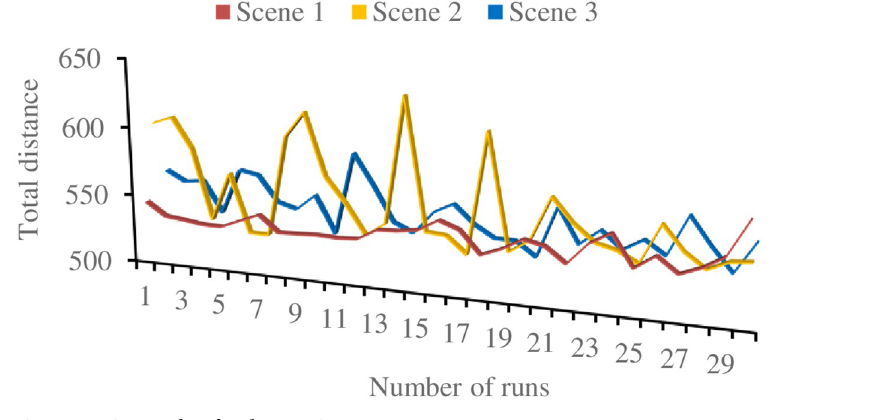
Fig 6. Running results of each scenario.